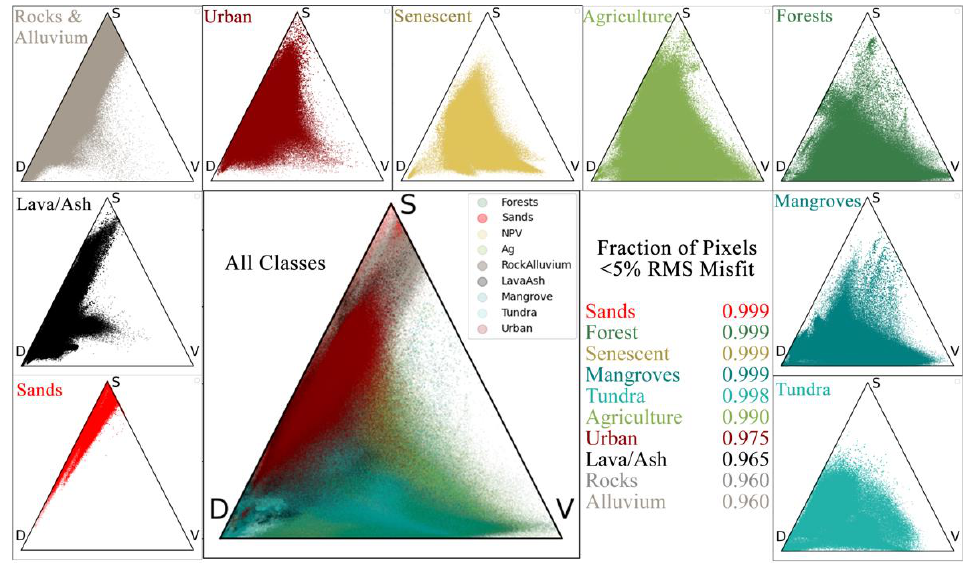
Figure 15. SVD fractions summarized by land cover type. Sands are dominated by S. Other geologic scenes show more mixing towards D. Urban, senescent, and agriculture show increasing mixing towards V, respectively. Forests, mangroves, and tundra then show decreasing S and increased skew towards binary V D mixing, respectively.